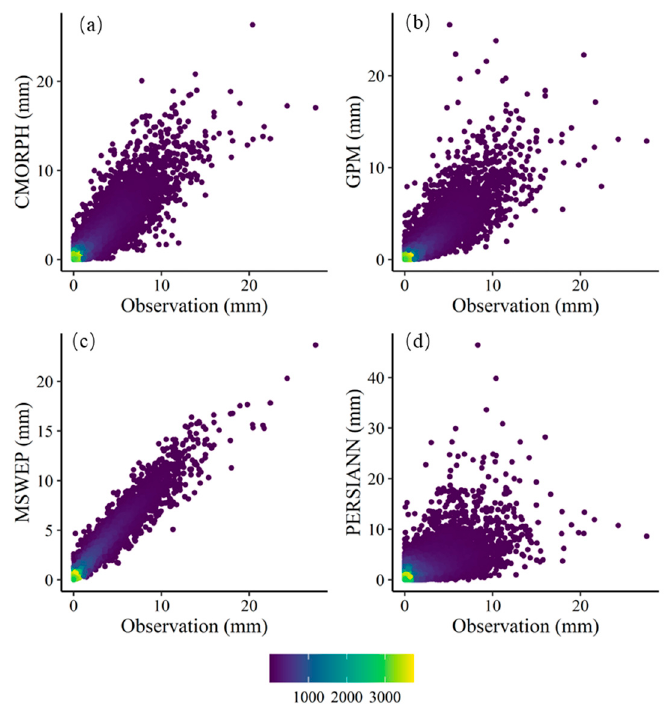
Figure 3. Scatter density map of the observations and daily data of ( a ) CMORPH, ( b ) GPM, ( c ) MSWEP and ( d ) PERSIANN datasets.